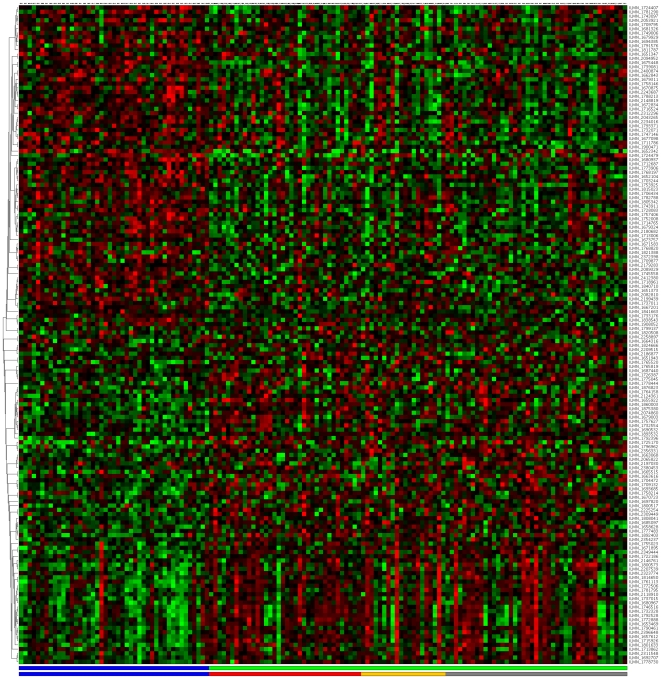
mRNA expression heatmap for the C/MS signature.Samples are placed along the horizontal axis and mRNA probe sequences along the vertical axis. Samples are colour-coded in the bottom horizontal bar (controls: blue; MS: green, as RR: red, SP: yellow, PP: grey). Clustering with a high-performance memetic algorithm (described in [285]) has ordered the samples and probe sequences, revealing four quadrants that are primarily up- (red) or down- (green) regulated. Note that division into up/down regulated is more coherent in the control samples than the MS samples.